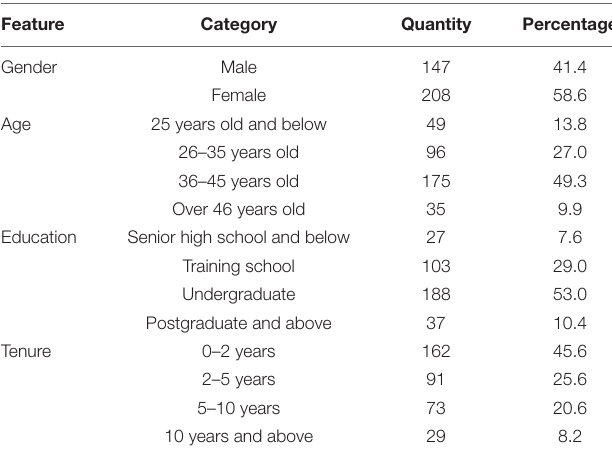
TABLE 1 | Demographic information ( n =